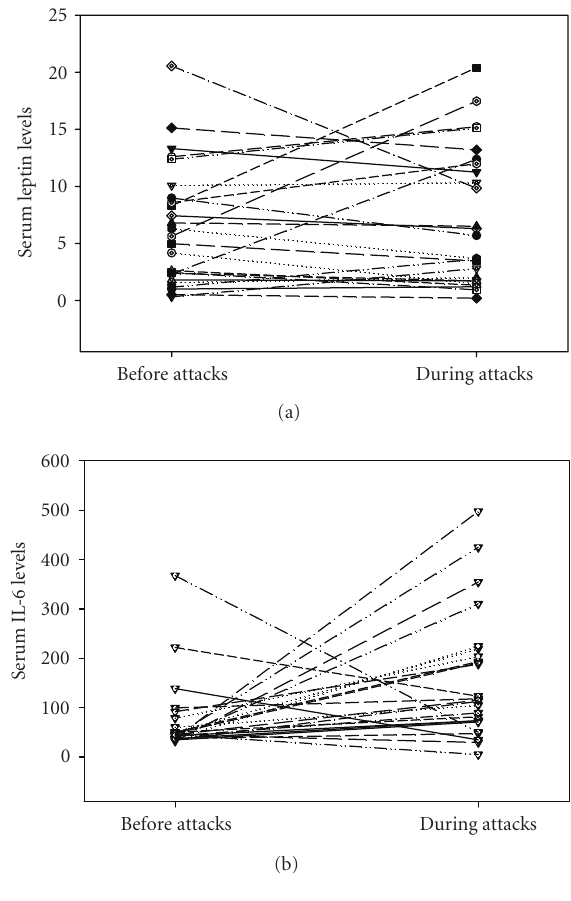
Figure 1: (a) Leptin levels before (Mean ± SEM: 6 . 4528 ± 1 . 05 ng/mL) and during (Mean ± SEM: 7 . 5928 ± 1 . 3 ng/mL) the at- tacks in FMF patients. Serum leptin levels did not increase signif- icantly during the attacks ( P > . 05). (b) Serum IL-6 levels before (Mean ± SEM: 70 . 18 ± 14 . 8 pg/mL) and during (Mean ± SEM: 163 . 32 ± 25 . 25 pg/mL) attacks. IL-6 levels increased significantly during the attacks ( P < .